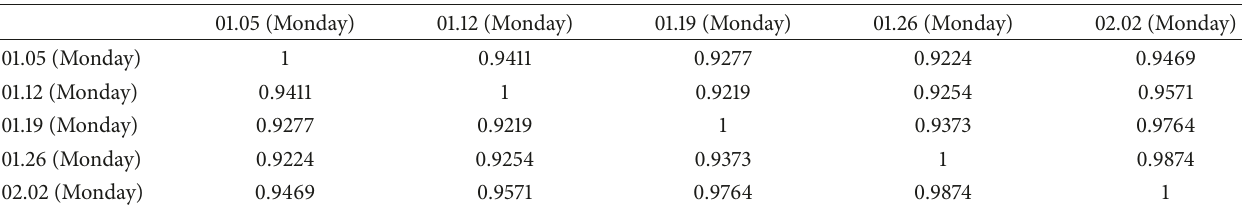
Table 5: Correlation coefficient matrices of two traffic volume series from the same detector located at urban arterial road but in different Monday.